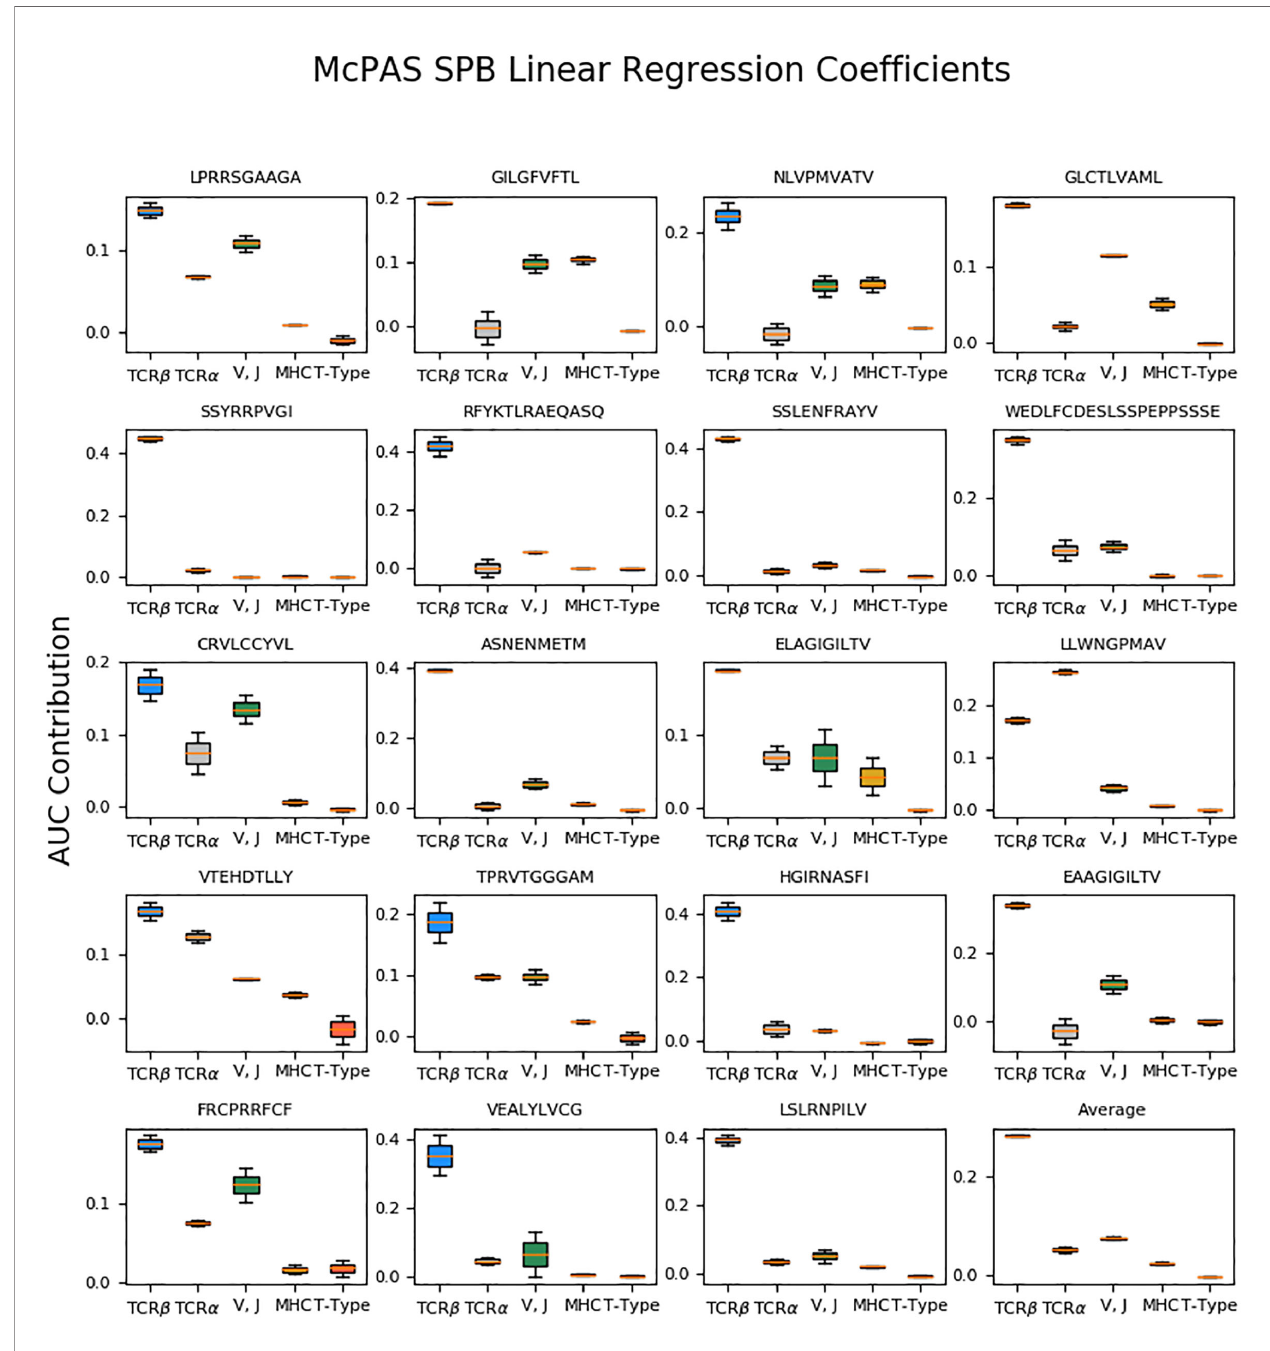
FIGURE 2 | Box plots of the inferred linear regression coef fi cients of the SPB results on McPAS (20) most frequent 19 peptides, and the average coef fi cients. The regression is performed on both AE-based and LSTM-based model results. The box size represents the 25 th and 75 th percentiles over different realizations, and error bars are 10 th and 90 th